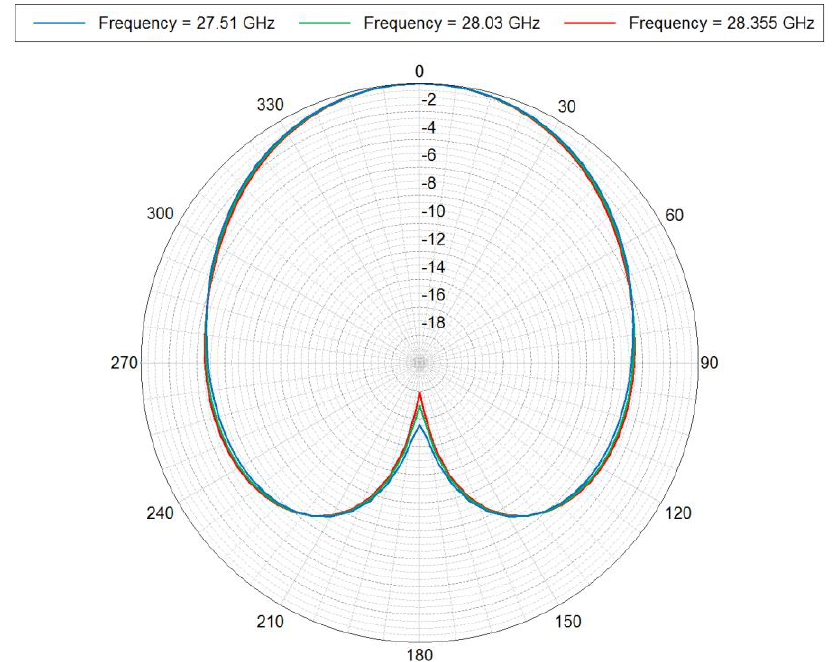
Figure 10. The three-dimensional (3D) view of radiation pattern for the proposed 5G antenna model at different frequen- cies. ( a ) 27.51 GHz; ( b ) 28.0 GHz; ( c ) 28.35 GHz.